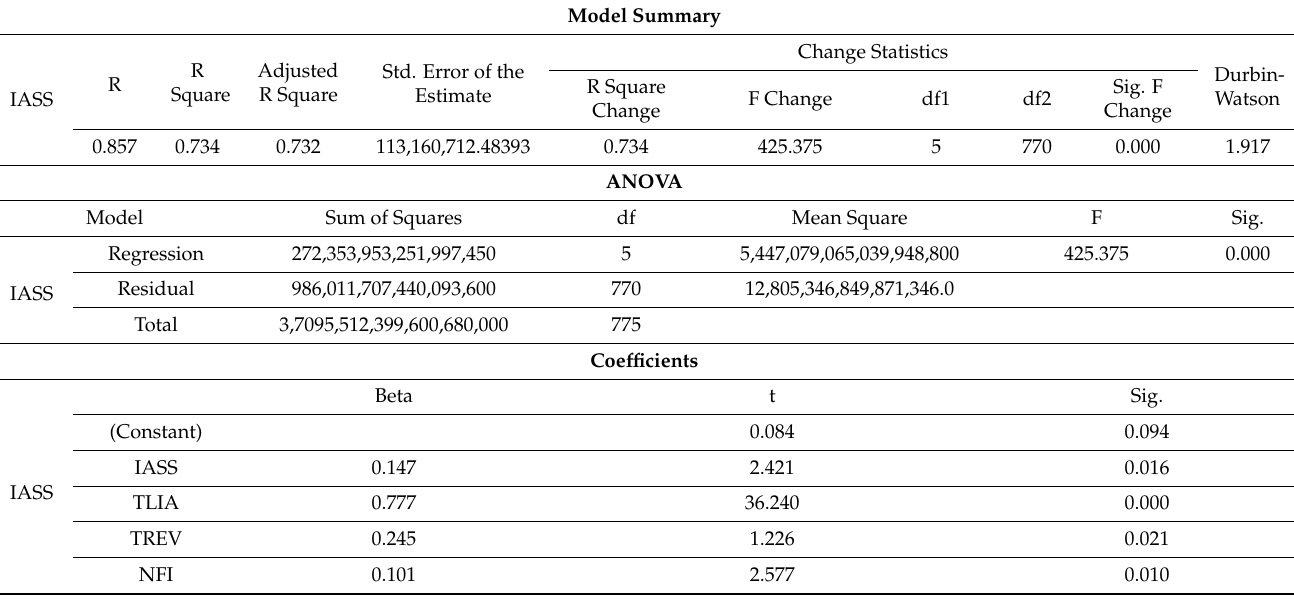
Table 10. Multiple regression analysis for factor (TASS).